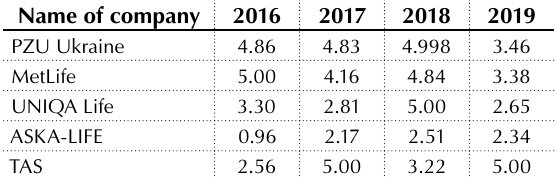
Table 5. Results of voting according to integral assessment in the category “Insurance services: life insurance (savings